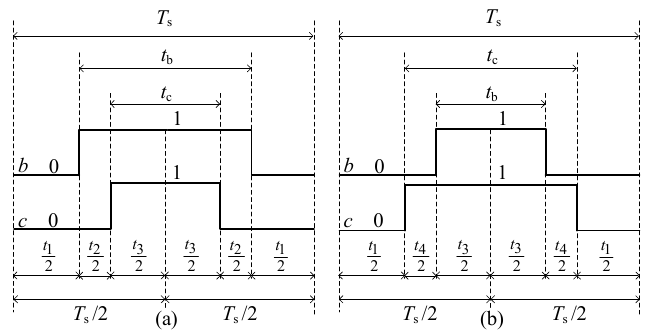
Figure 5. Switching sequence diagram ( a ) Switching sequence I ( b ) Switching sequence II.